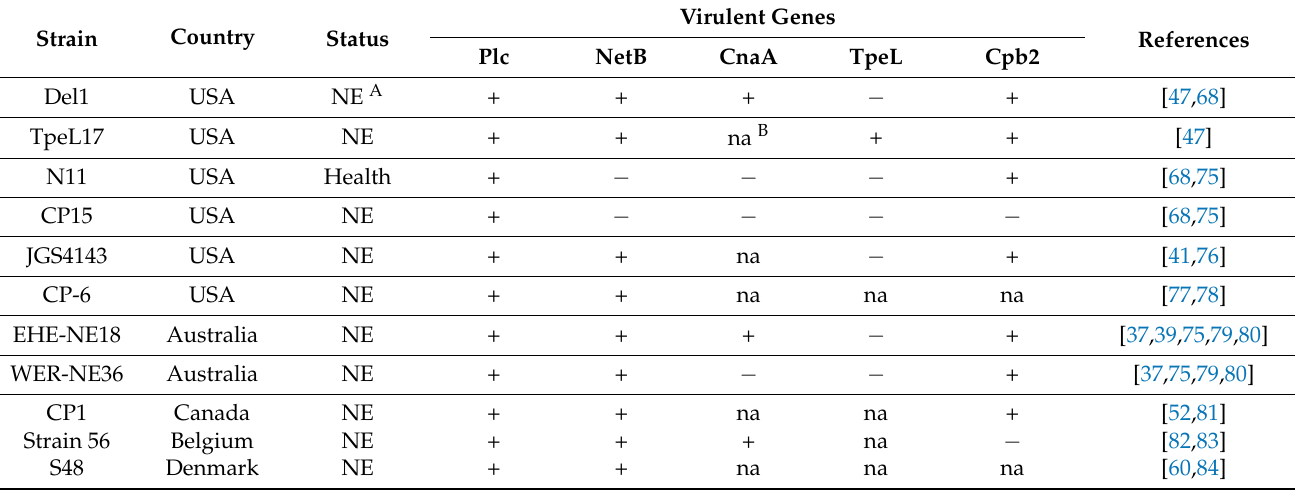
Table 3. NE strains often used in experimental NE